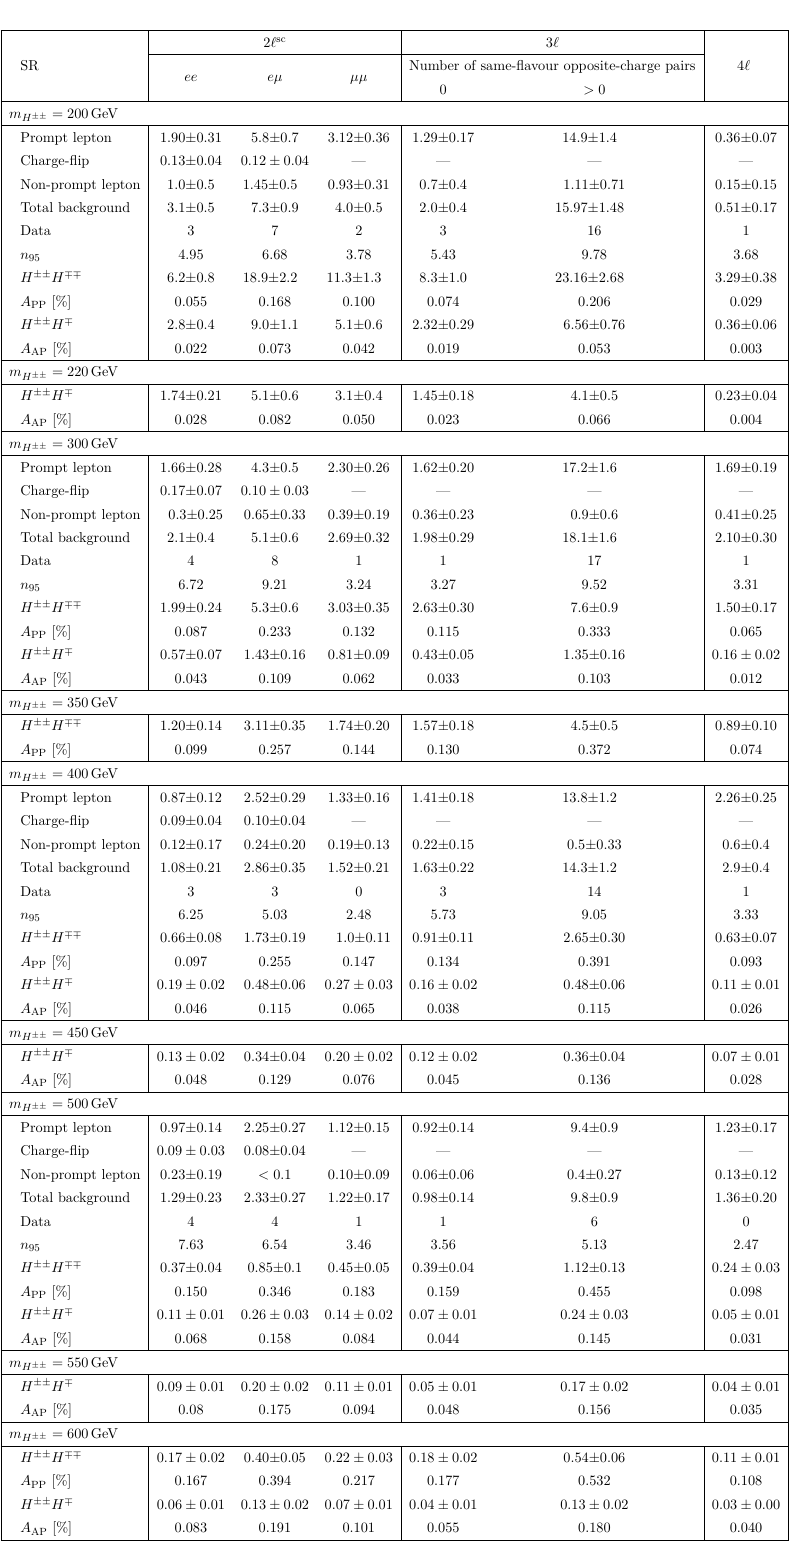
Table 8 . The expected background and the observed data event yields in the signal regions. More details are given in the